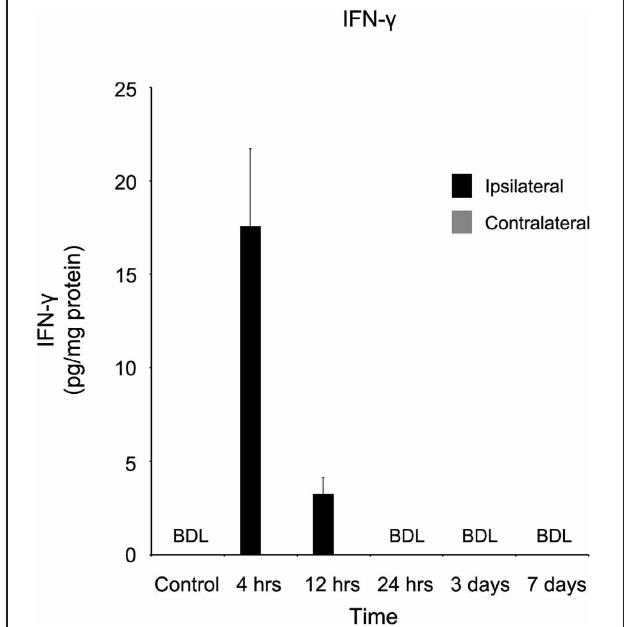
FIGURE 2 | IFN- γ concentration increases in the ipsilateral cortex four and 12 hours following a controlled cortical impact. Within four hours of a brain injury, IFN- γ increases ( p < 0 . 05) in the ipsilateral cortex in comparison to both control and contralateral tissue. At all time points, IFN- γ was below detectable limits (BDL) in both the control and contralateral tissue. Within 24 hours of the injury, IFN γ concentrations returned to below detectable limits. All values are mean ± SEM, n = 5. Since IFN γ in both control and contralateral tissue were below detectable limits, no statistical analyses were performed.